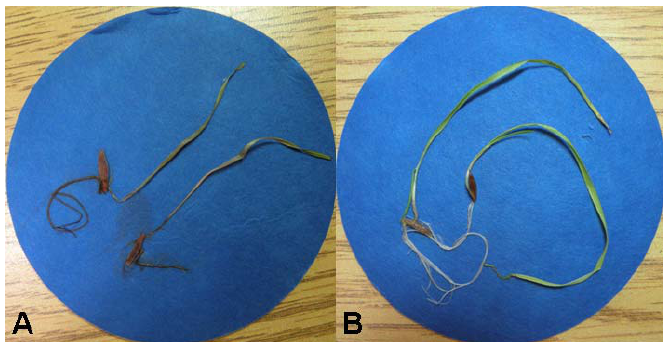
Figure 1. Juvenile plant immersion test on Bromus tectorum : ( A ) cheatgrass plants tested with CH 2 Cl 2 organic extract at 2 mg/mL after 10 days; ( B ) control.